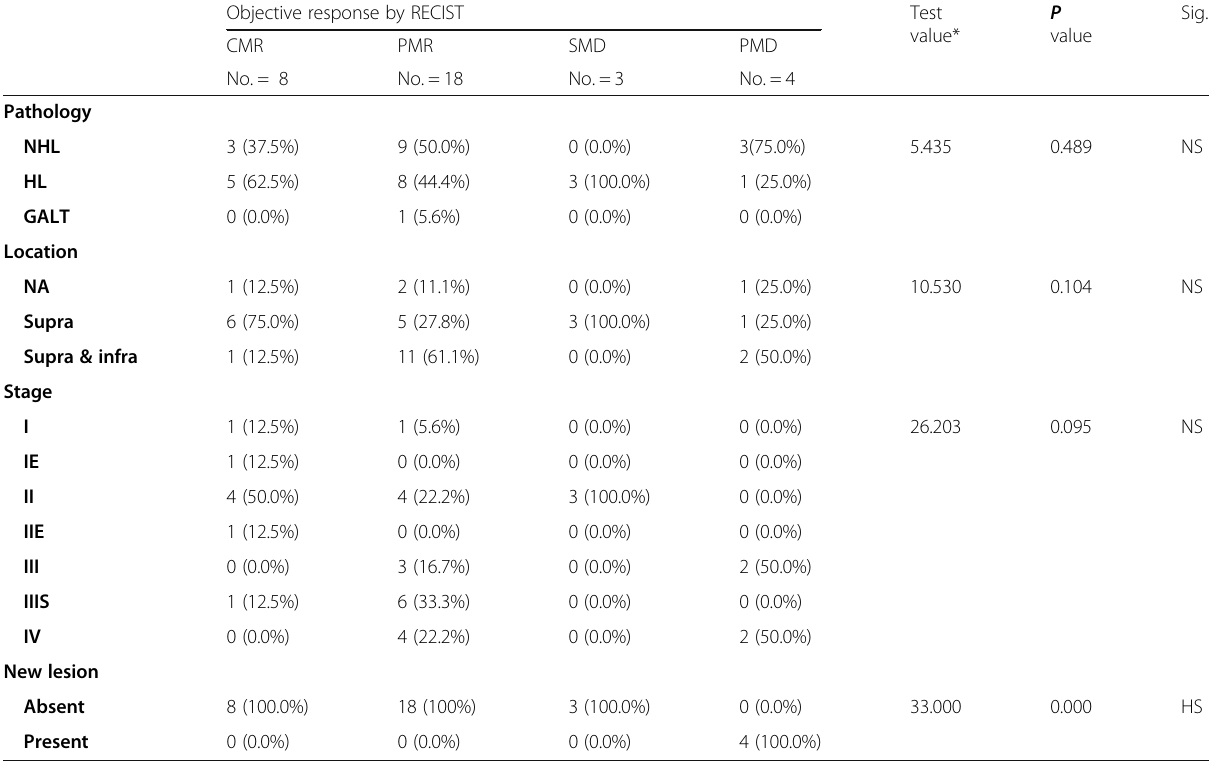
Table 5 Correlation between disease characteristics and CT-based therapeutic response in the study population Objective response by